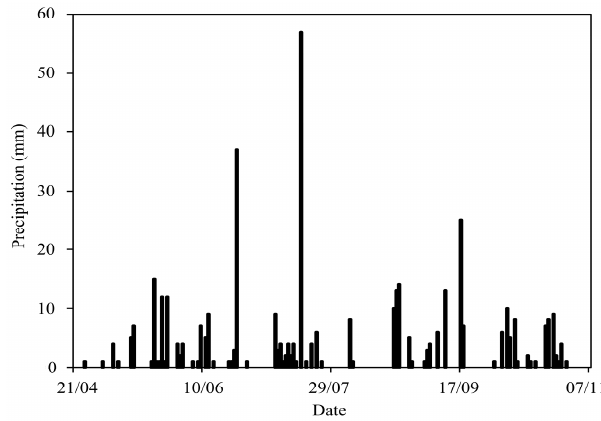
Figure 2. The distribution of daily precipitation during the study period in 2016. Table 1. The statistics for soil properties, leaf area index (LAI), slope gradient, and elevation across 48 observation points.